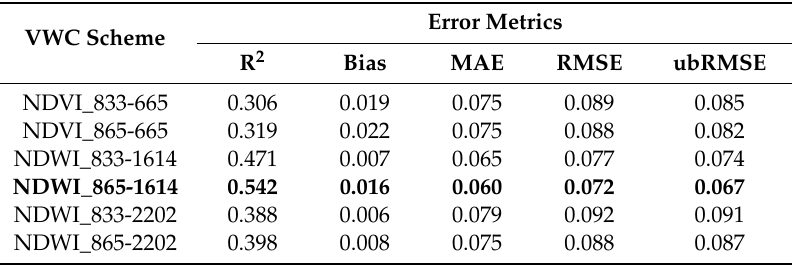
Table 3. Error metrics of soil moisture retrievals using the di ff erent VWC formulations. Results